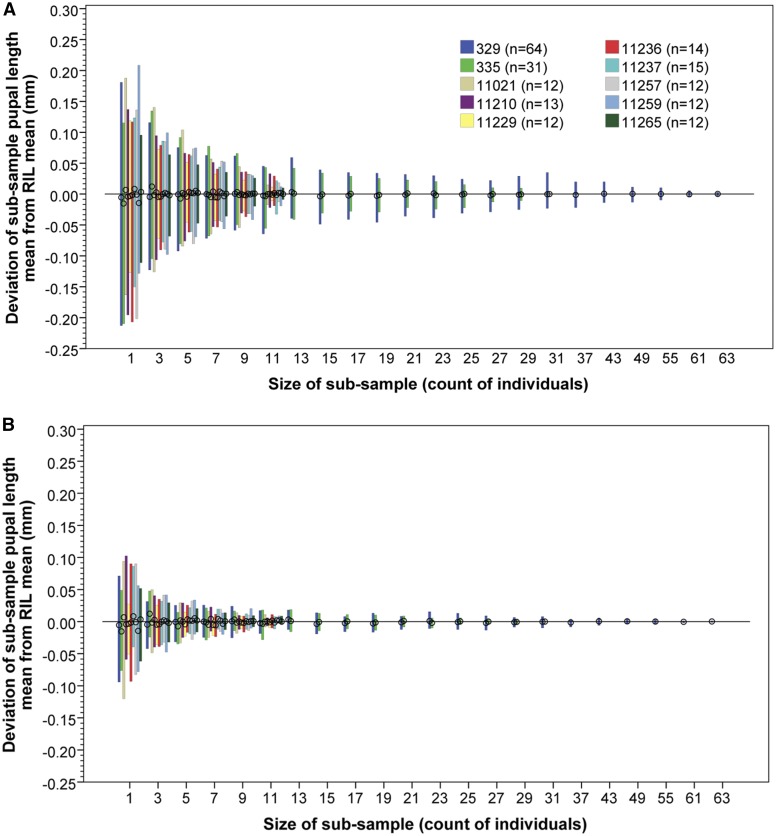
Deviation of mean RIL pupal length utilizing random subsamples of vials compared to that based on all measured vials. For all eight RIL, and two control stocks with 12 or more vial replicate measurements, the RIL mean pupal length was recalculated using a random subsample of vials. Each RIL was resampled 100 times per number of vial subsample size used. Whiskers represent range of subsample means, circles represent the overall means. (A) Range of 95% of subsamples; (B) 50% of subsamples. Total number of replicate vial measurements per RIL were as follows: RILs 11,229, 11,257, 11,259, 11,265, and 11,021 = 12 replicates; 11,210 = 13 replicates; 11,236 = 14 replicates; 11,237 = 15 replicates; 335 = 31 replicates; and 329 = 64 replicates. Note all pupae in vials were used to calculate each vial length mean, only the number of vial means in each subsample was varied in estimating length RIL means.